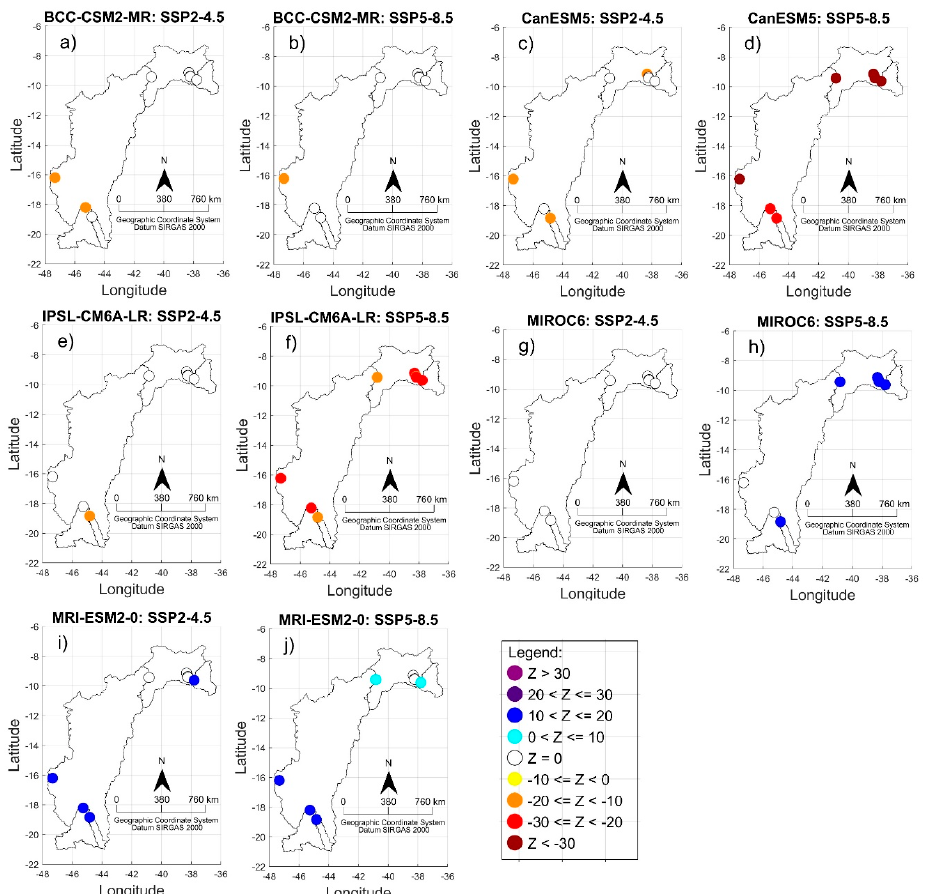
Figure 9. Trend, according to the Mann–Kendall Sen method of the standardized annual streamflow average, referring to the SSP2-4.5 and SSP5-8.5 scenarios of the CMIP6 (Intercomparison Model Project) for the period 2017–2100; ( a ) BCC- CSM2-MR: SSP2-4.5, ( b ) BCC-CSM2-MR: SSP5-8.5, ( c ) CanESM5: SSP2-4.5, ( d ) CanESM5: SSP5-8.5, ( e ) IPSL-CM6A-LR: SSP2-4.5, ( f ) IPSL-CM6A-LR: SSP5-8.5, ( g ) MIROC6: SSP2-4.5, ( h ) MIROC6: SSP5-8.5, ( i ) MRI-ESM2-0: SSP2-4.5, ( j ) MRI-ESM2-0: SSP5-8.5.